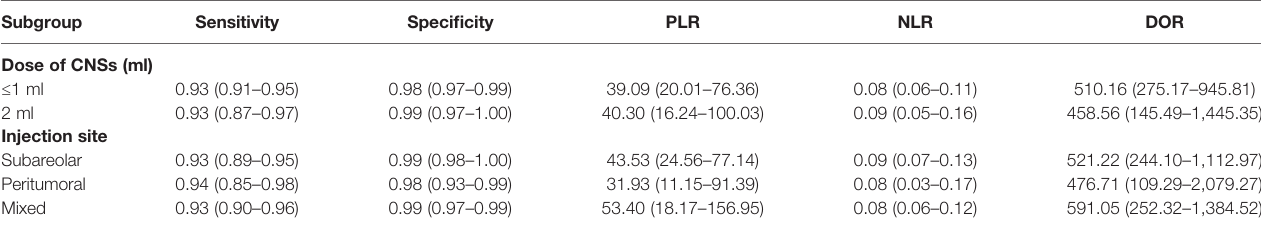
TABLE 2 | Subgroup analysis was performed based on Carbon Nanoparticle injection doses and site. Subgroup